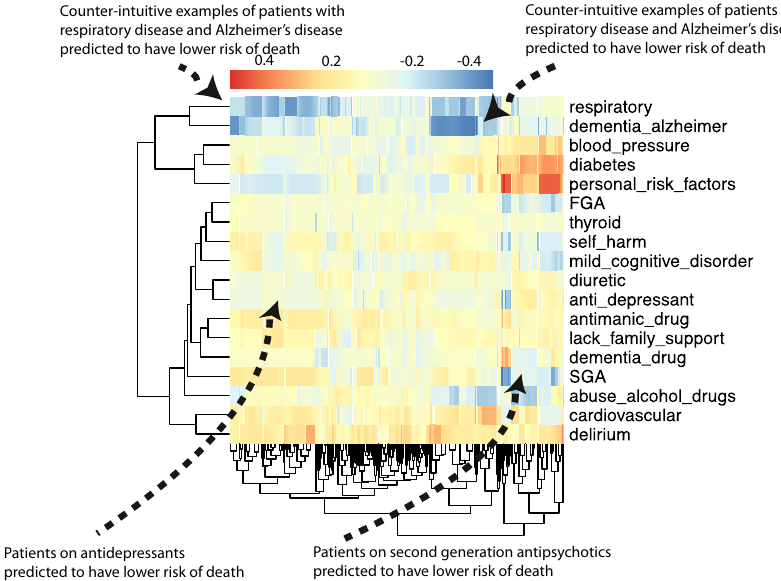
Fig. 6 Class-contrastive heatmap for the deep learning model. Visualization of the amount of change predicted in the probability of death by setting a particular feature to 1 versus 0. Predictions are made on the test set using a random forest model built on top of the autoencoder. Columns represent patients and rows represent features. The arrows at the top indicate counter-intuitive examples. If these patients had a respiratory disease or Alzheimer ’ s disease, the model predicts low risk of death. The arrows at the bottom indicate a group of patients on antidepressants and SGA who are predicted to have low risk of death. The heatmap also shows a hierarchical clustering dendrogram, which is performed using an Euclidean distance metric and complete linkage. We note that even though we cluster the features (columns) we do not aim to imply any similarity between them. FGA: fi rst-generation